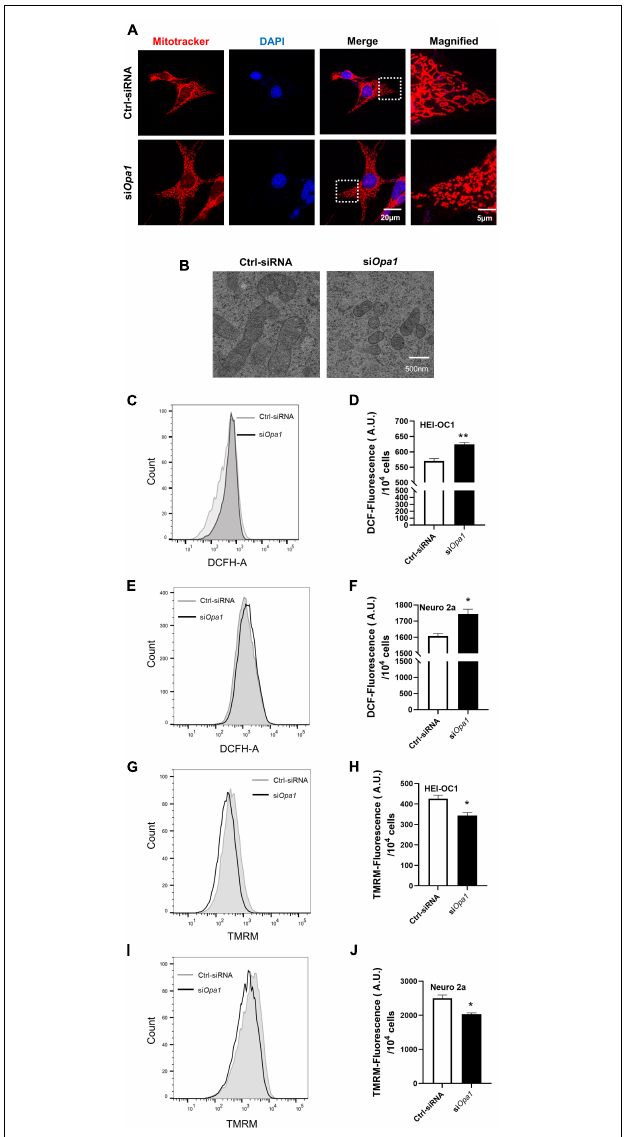
FIGURE 2 | Loss of Opa1 leads to mitochondrial dysfunction in HEI-OC1 and Neuro 2a cells. (A) Representative confocal microscopic images of MitoTracker staining at 24 h after siRNA transfection of HEI-OC1 cells. Right panels show magnified views of the areas marked in the left panels. (B) HEI-OC1 cells were transfected with scramble (Ctrl) siRNA or si Opa1 for 24 h and fixed, and thin sections of cells were visualized by transmission electron microscopy. (C) Intracellular ROS level was measured by flow cytometric analysis using DCFH-DA in HEI-OC1 cells transfected with siRNA for 24 h. (D) Quantitative histograms of the mean fluorescence intensity of DCFH-DA in HEI-OC1 cells. ** p < 0.01 (non-parametric Mann-Whitney t -test). (E,F) Representative flow cytometric plot (E) and quantitative histograms (F) of the mean fluorescence intensity of DCFH-DA in Neuro 2a cells transfected with siRNA for 24 h. * p < 0.05 (non-parametric Mann-Whitney t -test). (G) The mitochondrial membrane potential of HEI-OC1 cells was measured by flow cytometric analysis using TMRM fluorescence at 24 h after siRNA transfection. (H) Bar graph shows the relative TMRM mean intensity in HEI-OC1 cells. * p < 0.05 (non-parametric Mann-Whitney t -test). Representative flow cytometric plot (I) and quantitative histograms (J) of the relative TMRM mean intensity in Neuro 2a cells. * p < 0.05 (non-parametric Mann-Whitney t